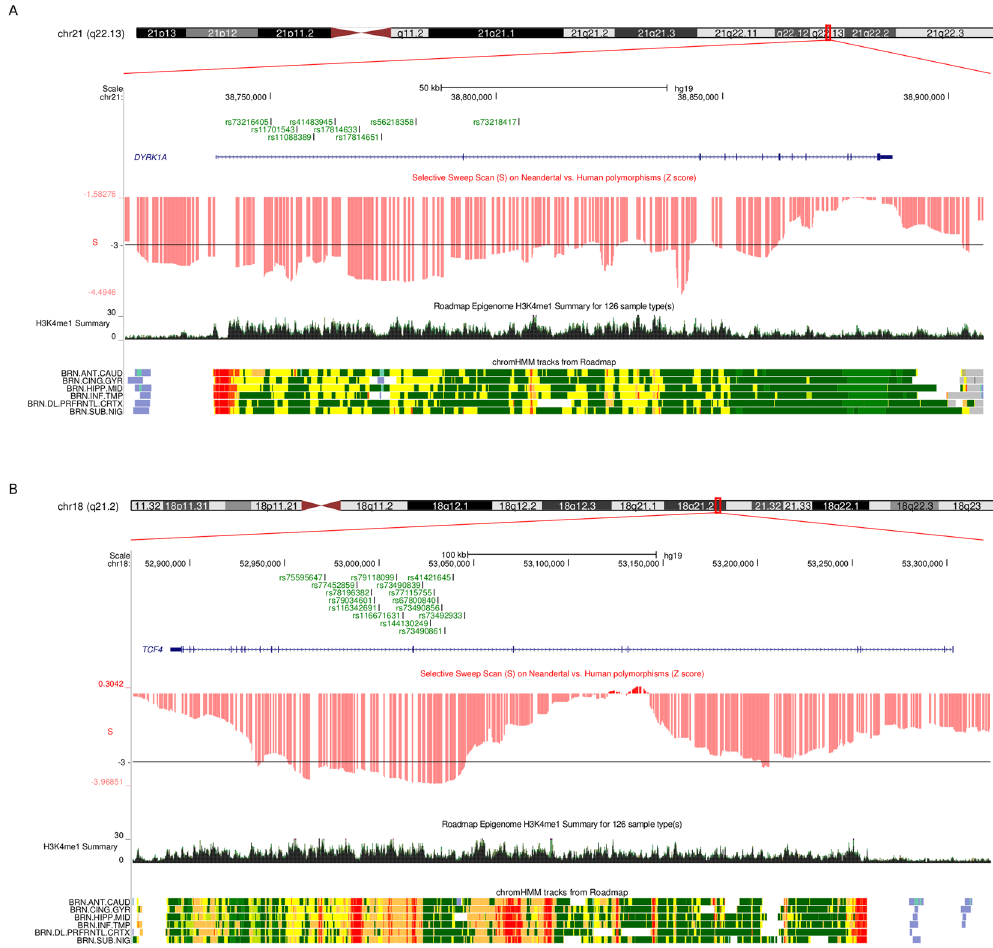
Figure 7. DYRK1A and TCF4 modern human alleles. Modern-human-specific SNPs and their location in DYRK1A ( A ) and TCF4 ( B ) are shown within the UCSC Genome Browser view. S scores are shown in red. The horizontal black line represents the 5 th percentile of S score. Relevant annotation tracks from the Roadmap Epigenomics Data Complete Collection at Wash U Viz Hub are also shown, filtered for brain tissues